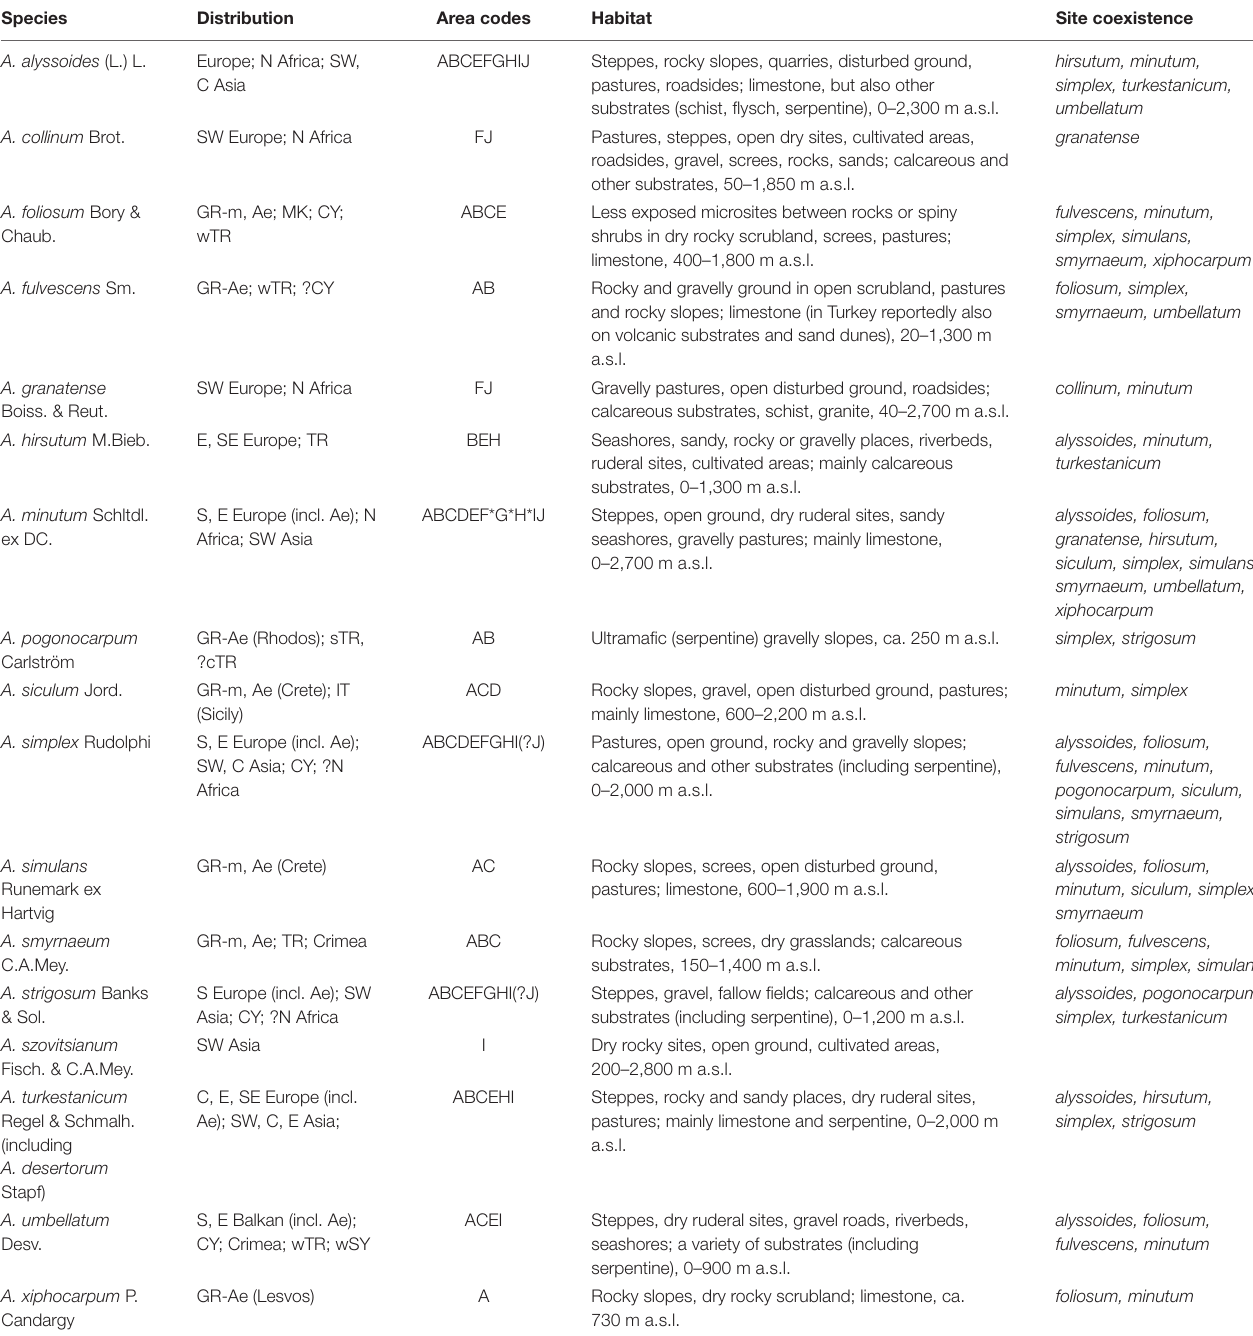
TABLE 1 | Overview of the studied Alyssum annual species (listed alphabetically), including their distribution ranges, habitat characteristics and site coexistence with other species.